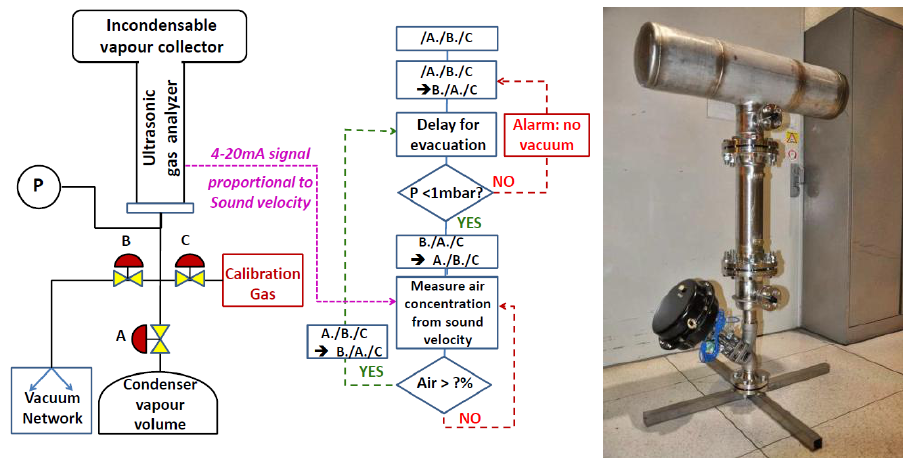
Figure 6. The schematic and logic flow of the leak detection system of the condenser headspace of the ATLAS inner detector thermosiphon cooling system is shown on the